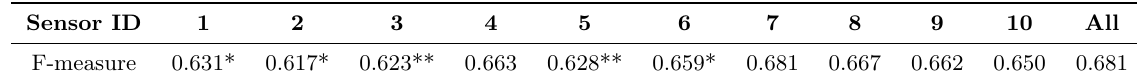
Table 6. Average F-measures of 20 users for individual sensor and all sensors (rightmost column). A single asterisk and a double-asterisk indicate that there is significant difference between the F-measures of “All” and a particular sensor at the confidence level of p < .05 and p < .01, respectively.